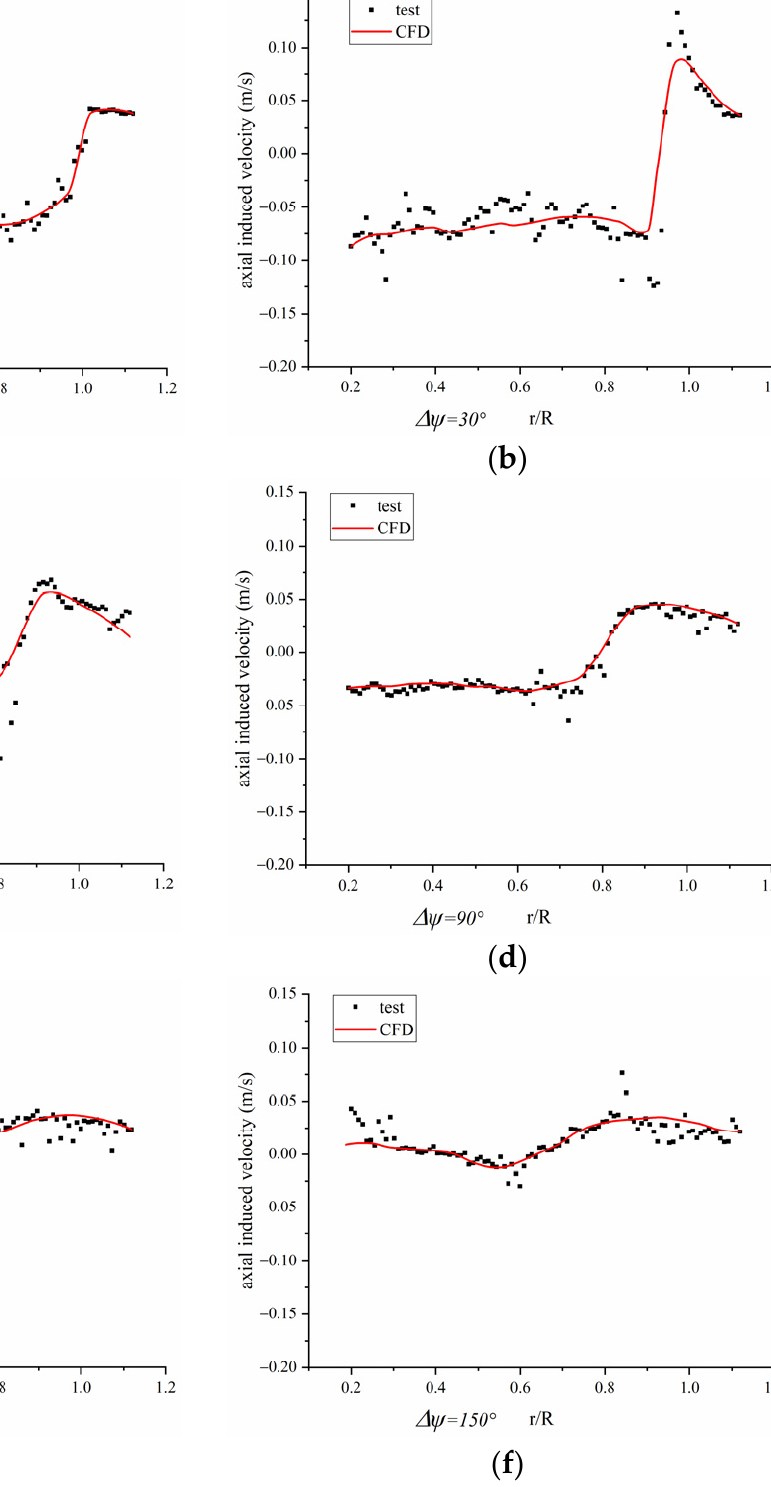
Figure 11. Axial induced velocity at 𝜓 = 180 ° .